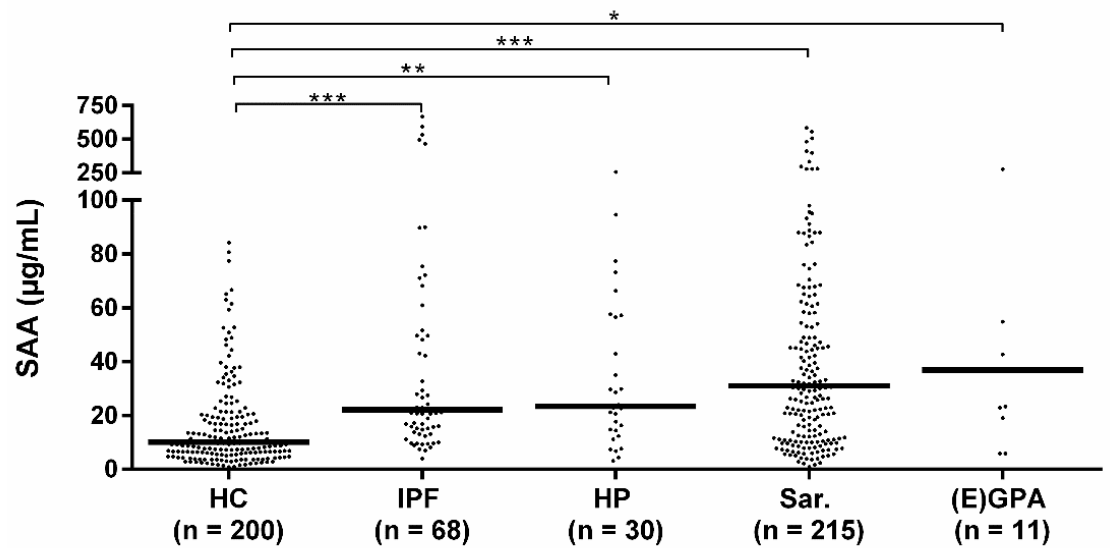
Figure 1. Serum amyloid A (SAA) levels in patients and healthy controls. Median SAA levels of idiopathic pulmonary fibrosis (IPF) (22.1 IQR 55.5), HP (23.4 IQR 43.4), sarcoidosis (31.0 IQR 56.3) and (E) GPA patients (36.9 IQR 123.7) were all higher than the median SAA level of healthy controls (10.1 IQR 15.6). Median SAA levels did not significantly differ between the diagnostic groups. HC: healthy control, Sar: sarcoidosis, HP: hypersensitivity pneumonitis, (E) GPA: (eosinophilic) granulomatosis with polyangiitis ((E) GPA), IPF: idiopathic pulmonary fibrosis. *, **, *** p -values were calculated using Kruskal–Wallis test including pairwise comparisons.